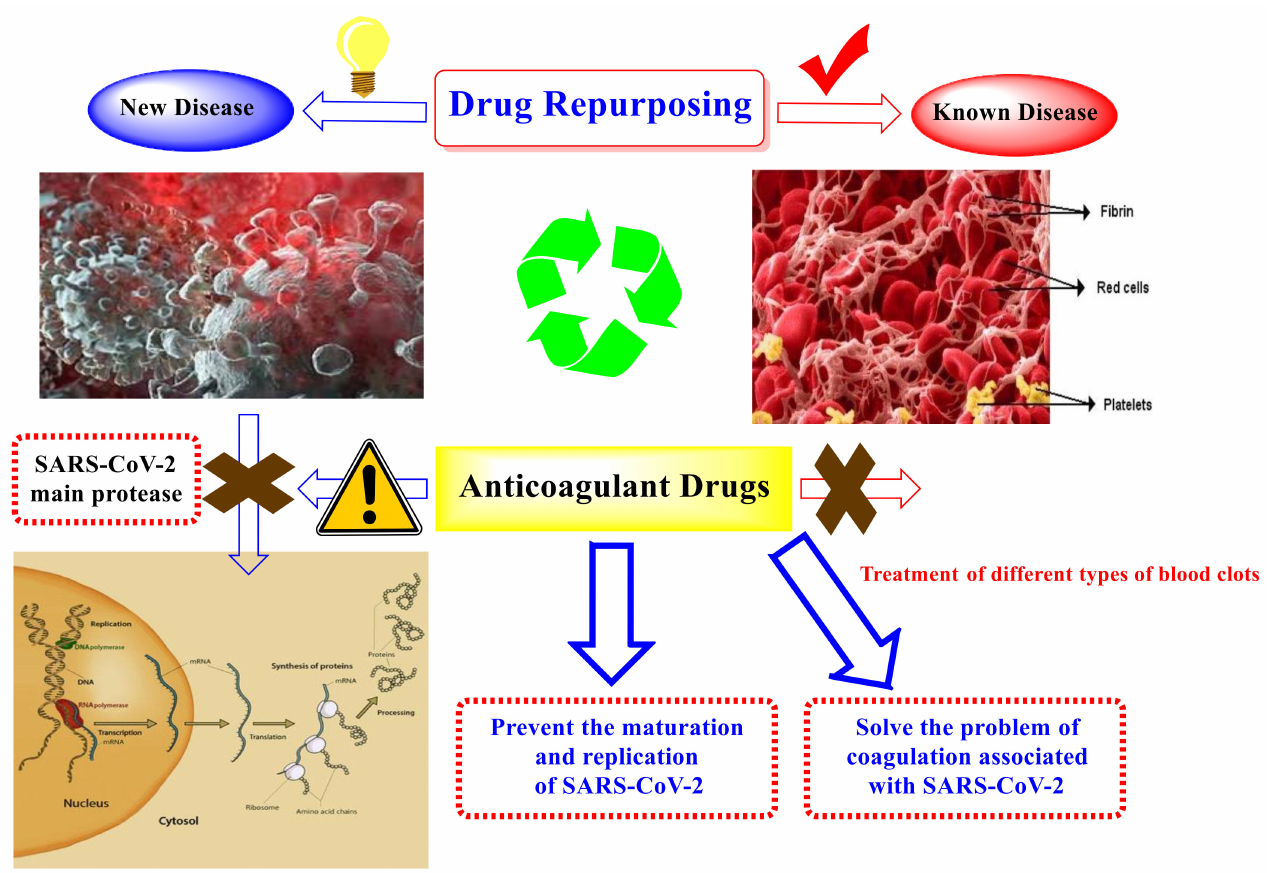
Figure 2. A graphical representation of the anticoagulants repositioned as SARS-CoV-2 inhibitors, showing their role in COVID-19 patient